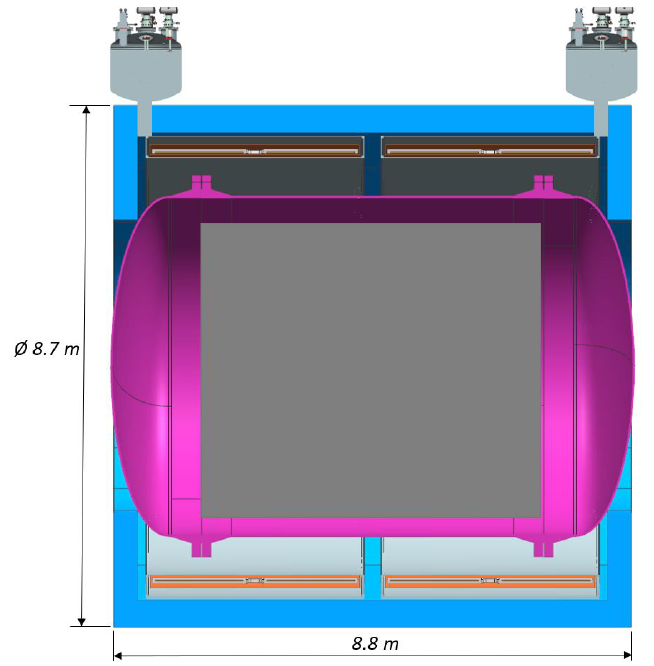
Figure 52. Solenoid arrangement for ND-GAr superconducting